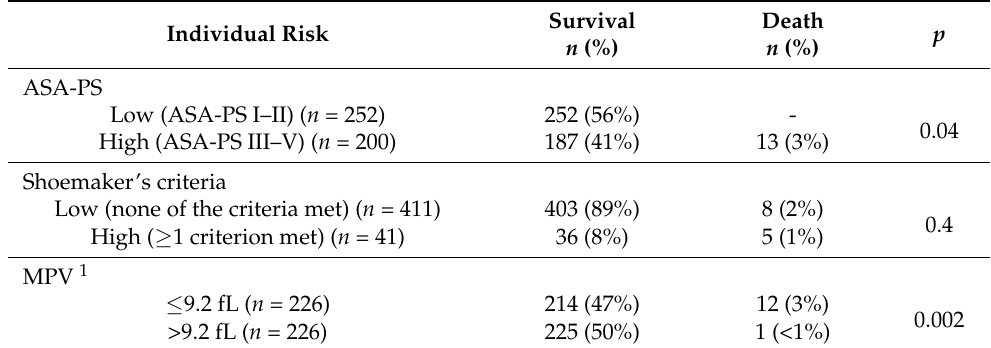
Table 6. Individual risk and treatment